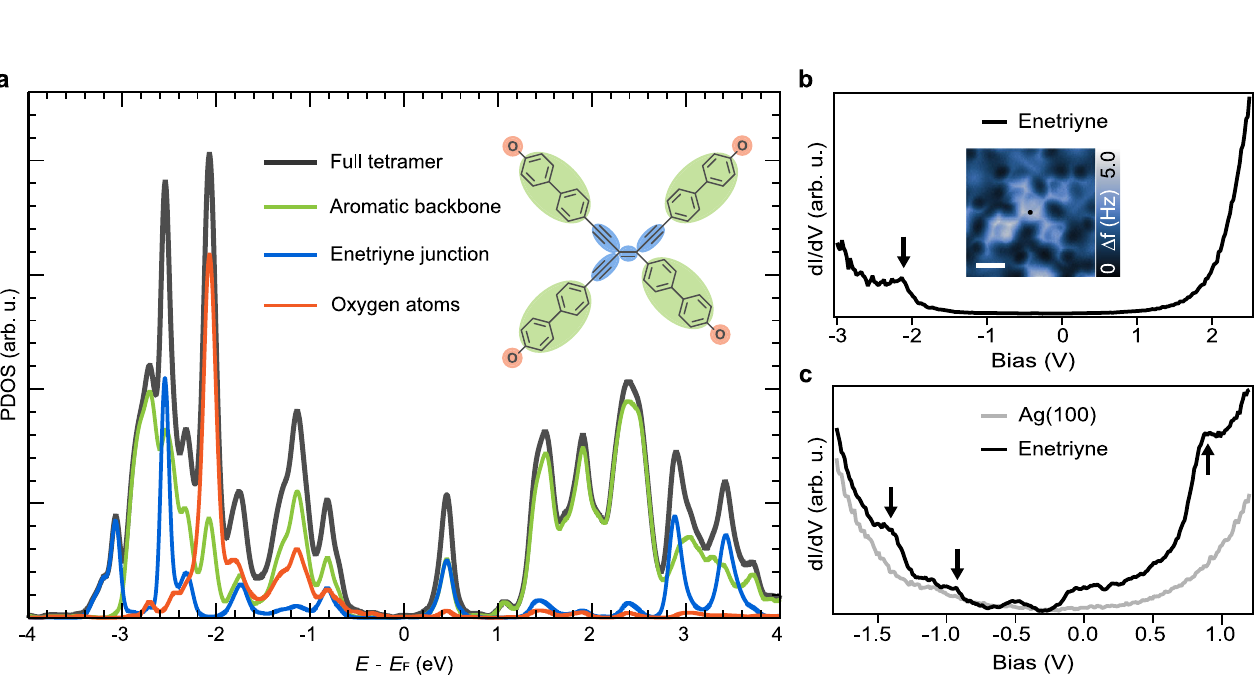
tetramer as indicated by the black point on the inset AFM image. Scale bar is 5Å. c dI/dVspectrum( −